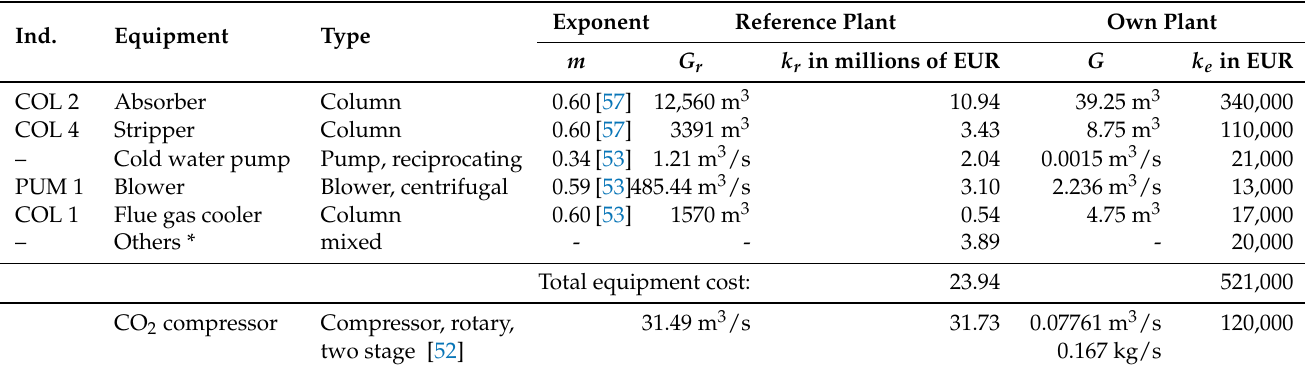
Table 7. Equipment cost calculation. Indicators (Ind.) refer to Figure 2b for the easier identification of equipment. * Remaining heat exchanger and pumps with less significant influence on the total component